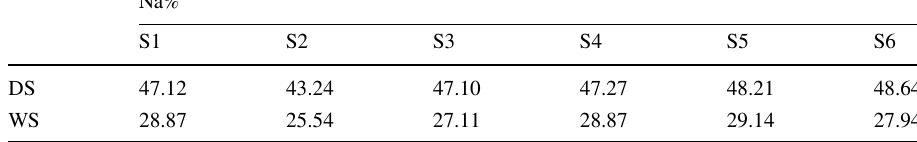
Table 6 Na% values of Shatt